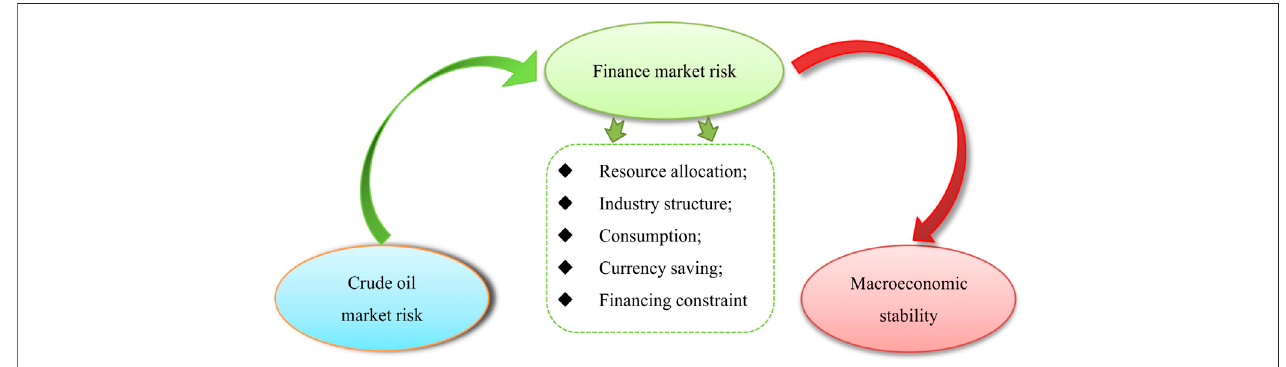
FIGURE 2 | Formation mechanism of the channel effect of fi nancial market